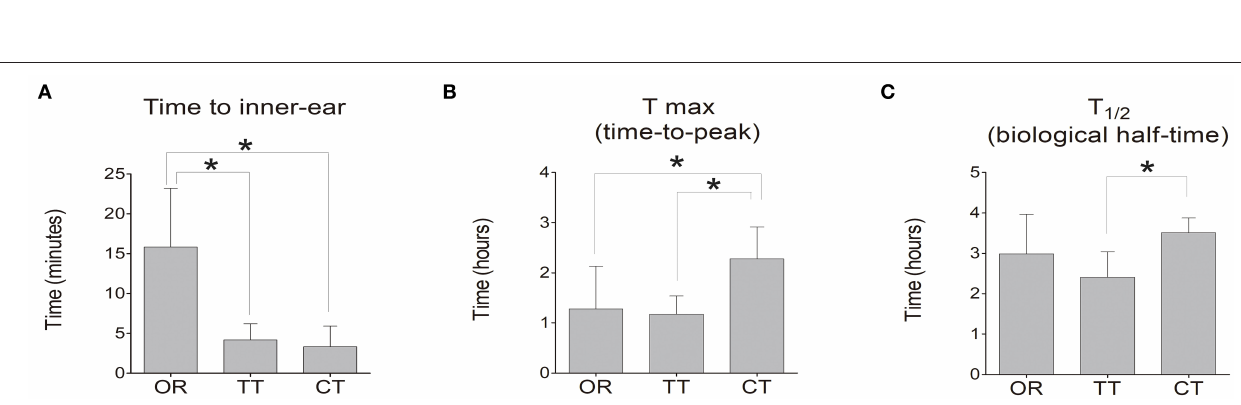
Frontiers in Neurology |